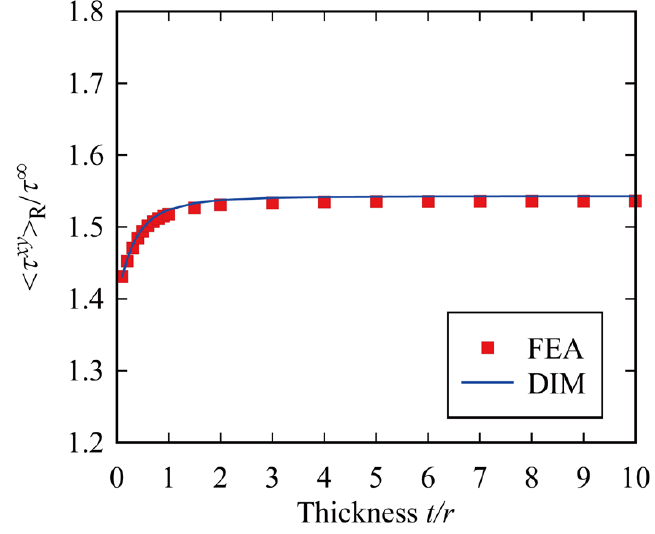
of each phase is normalized by the remote stress 𝑥𝑥𝑦𝑦 〉 〈𝜏𝜏